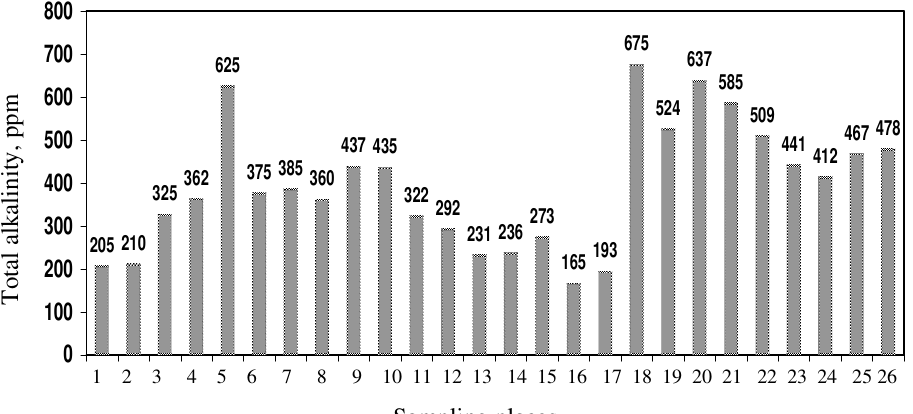
Figure 5. Alkalinity of various water samples collected in and around